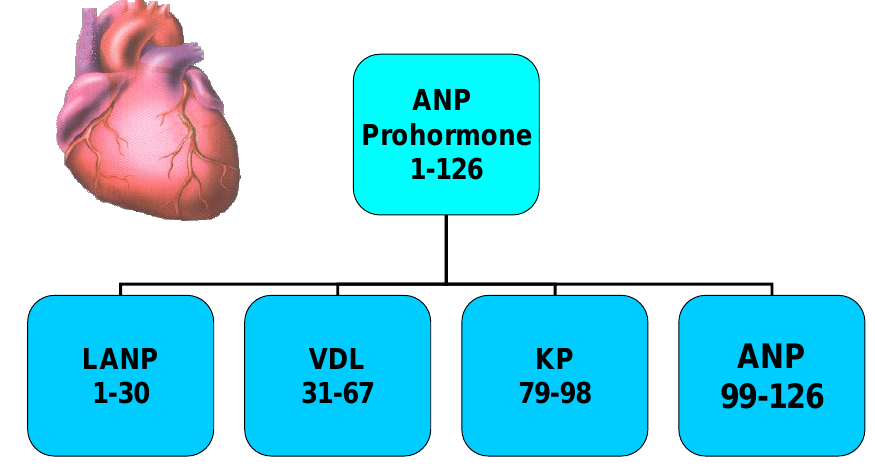
Figure 1. The atrial natriuretic peptide gene in the heart synthesizes a 126 amino acid (a.a.) prohormone with which proteolytic processing results in the formation of four cardiac hormones. These four cardiac hormones, i.e. , ( 1 ) long acting natriuretic peptide (LANP) consists of the first 30 amino acids of the 126 a.a. prohormone; ( 2 ) vessel dilator (VDL), a.a. 31-67 of the prohormone; ( 3 ) kaliuretic peptide (KP), a.a. 79-98 of this prohormone and ( 4 ) atrial natriuretic peptide (ANP), consisting of a.a. 99-126 of the 126 a.a. prohormone. Reprinted with permission from